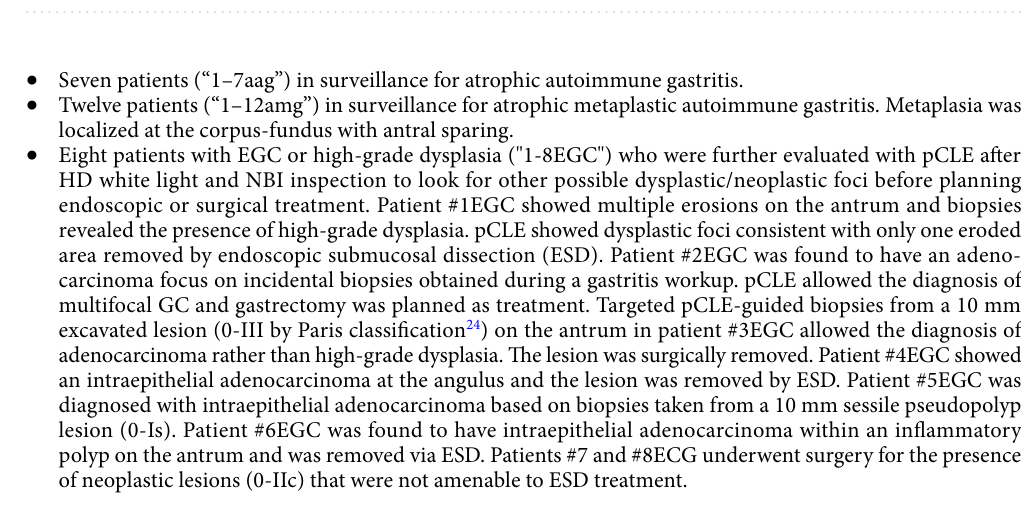
Table 3. Vascular and gastric pit pattern features in patients analyzed by pCLE. Bold characters highlight that all cases (100%) show the specific vascular alteration/characteristic and the specific gastric pit pattern.